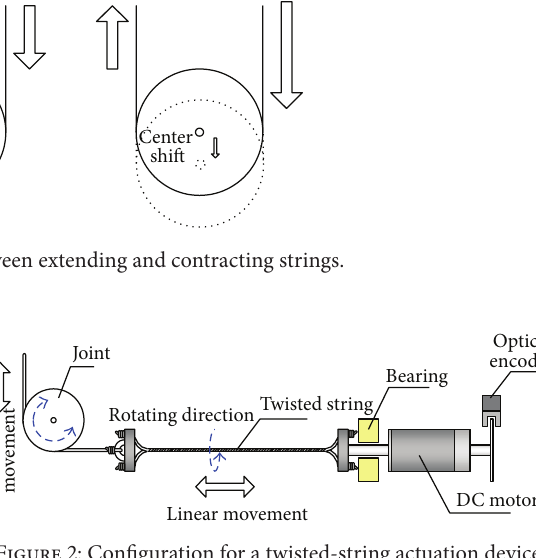
Figure 2: Configuration for a twisted-string actuation